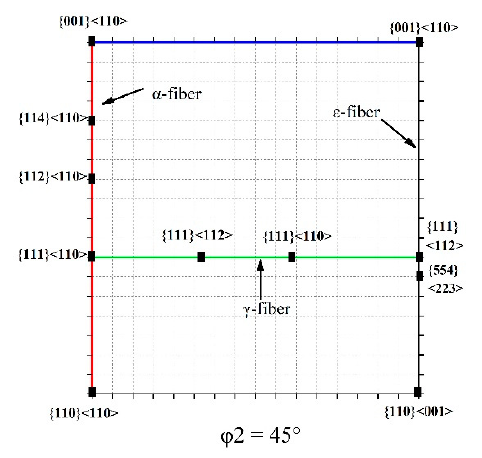
Figure 2. Typical texture components of IF steel in φ 2 = 45° ODF (orientation distribution function) section.